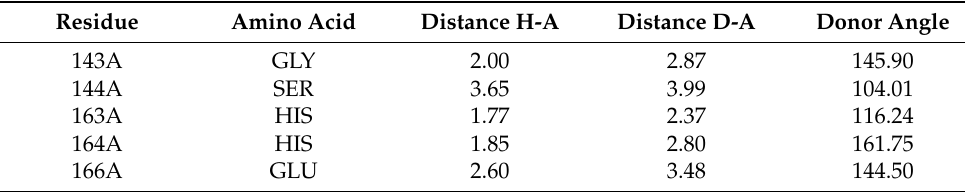
Figure 1. The active site of SARS-CoV-2 Mpro. Table 1. Active site residues of SARS-CoV-2 Mpro. Table 1. Active site residues of SARS-CoV-2